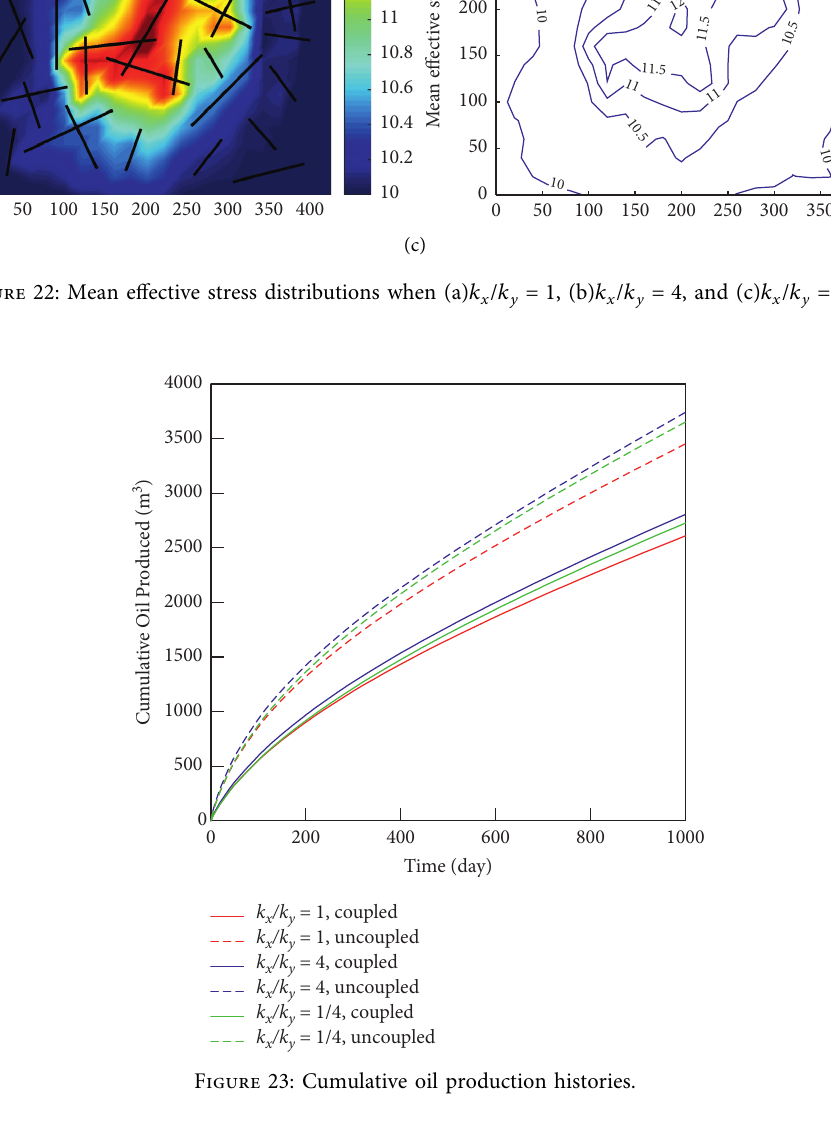
Figure 23: Cumulative oil production